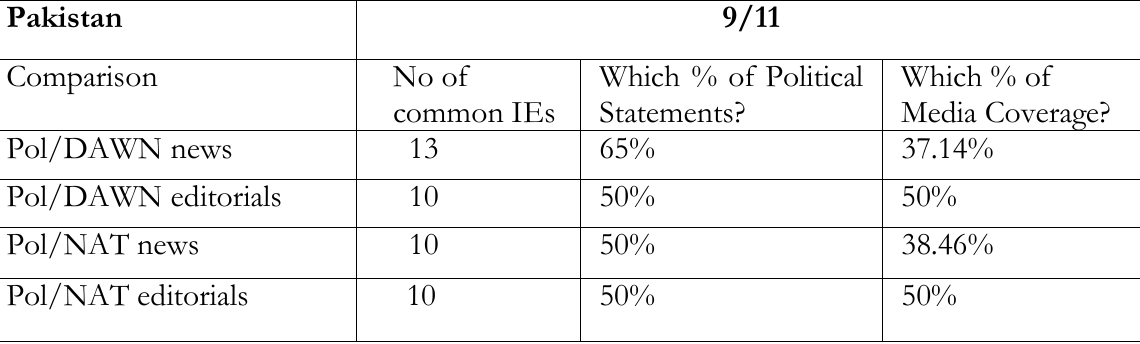
Table 8. Comparisons between political statements, first page news, and editorials in